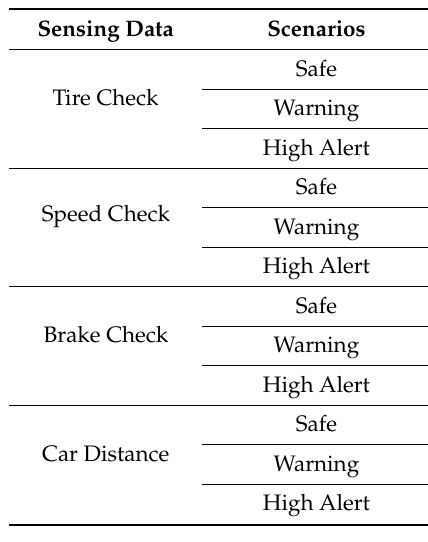
Table 4. Smart car sensing data scenario classification for building